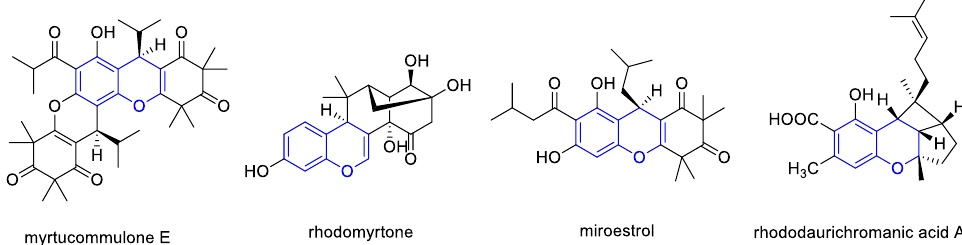
Figure 1. Representative examples of natural products and biologically active compounds with a ring-fused chroman